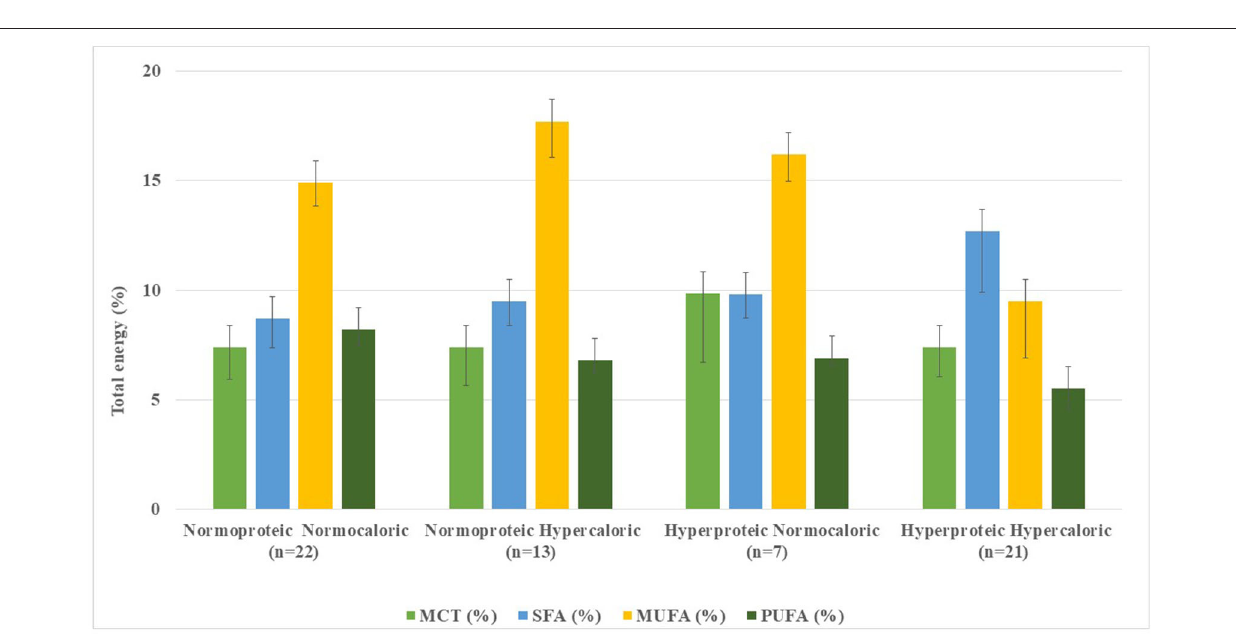
FIGURE 3 | Distribution of fatty acids and medium-chain triglycerides content in standard enteral formulae per 1,500 kcal infused. are not well controlled due to the disease states (19, 28, 29,